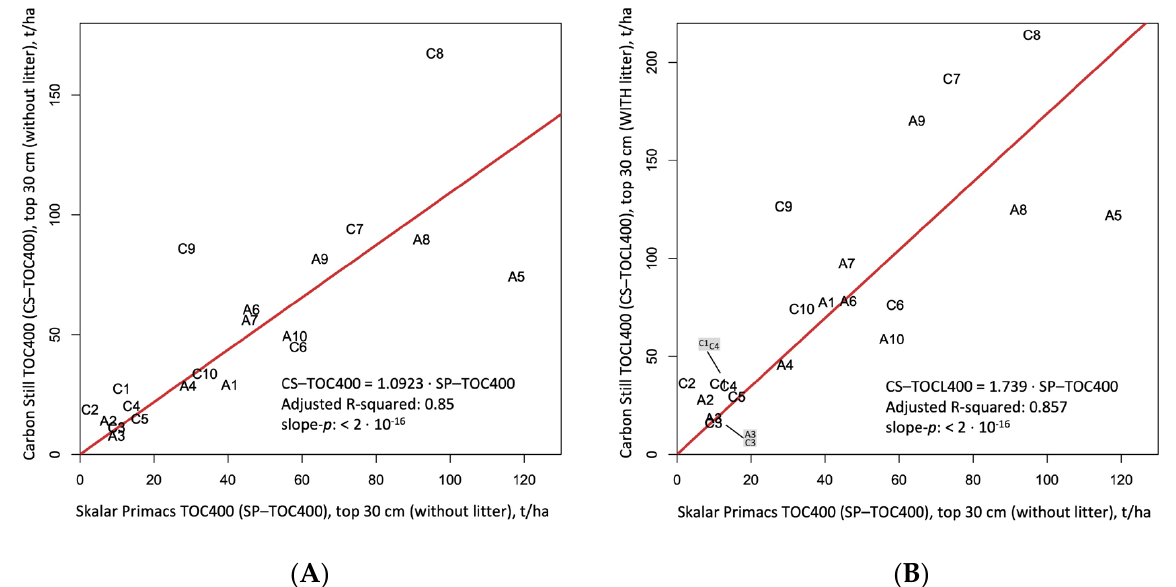
Figure 10. ( A ) Linear regressions between organic carbon estimated in organic mineral soil samples with Carbon Still (CS–TOC400) and Skalar Primacs (SP–TOC400). ( B ) Linear regressions between organic carbon estimated in organic mineral soil plus in litter samples with Carbon Still (CS–TOCL400) and organic carbon estimated in organic mineral soil samples with Skalar Primacs (SP–TOC400). Sliding from left to right on the graphs you go from the beach into the forest at the two sites (A = Albarella; C = Caleri): 1–2 = beach; 3–4 = dune; 5–6 = shrubland; 7–8 = forest; 9–10 = other (two humid areas in Caleri; flower bed, and new plantation in Albarella).